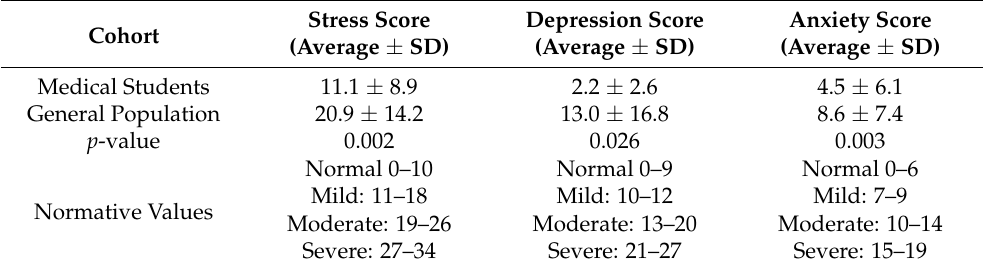
Table 2. Scores obtained for depression, anxiety, and stress scale (mean ± standard deviation). Comparisons are between medical students and general population (Student’s unpaired t -tests). Normative values for each subscale are presented (Crawford and Henry 2003).